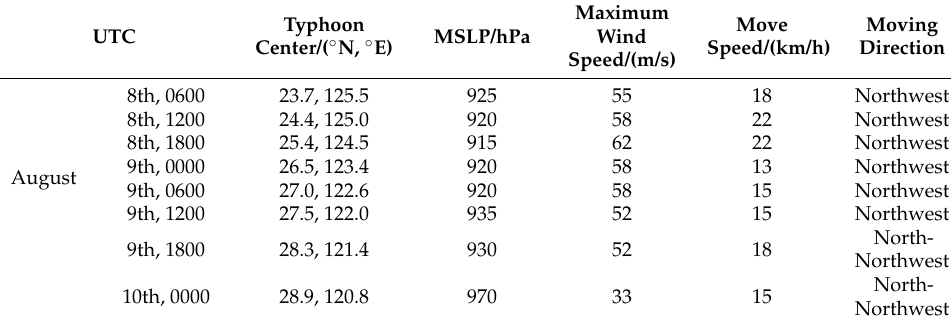
Table 3. Super typhoon Lekima